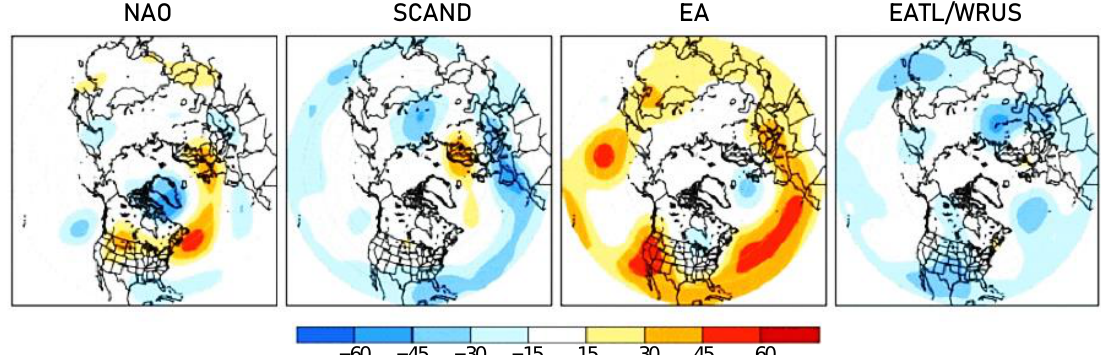
Figure 3. The loading patterns for the four macroscale circulation patterns for July. The plotted value at each grid point represents the temporal correlation between the monthly standardized height anomalies at that point and the teleconnection pattern time series [33].